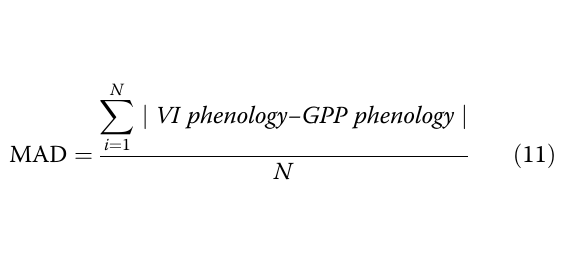
Fig. 2 Seasonalities of gross primary production and vegetation indices during 2008 – 2018. NDVI B : broadband normalized difference vegetation index, EVI B : broadband enhanced vegetation index, NIRv B : broadband near-infrared albedo of vegetation, NDVI M : MODIS normalized difference vegetation index, EVI M : MODIS enhanced vegetation index, NIRv M : MODIS near-infrared reflectance of